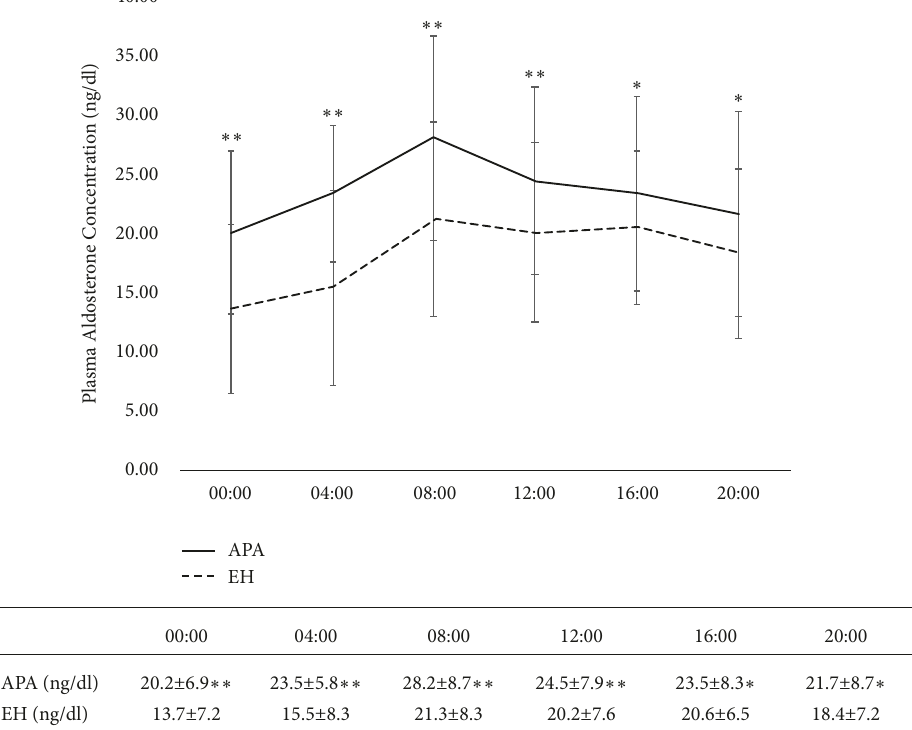
Figure 1: The circadian change in relation to plasma aldosterone concentration vs. that in the EH group. ∗ P < 0.05; ∗∗ P < 0.01. Note: the solid line refers to patients with APA, while the dashed line refers to patients with EH. APA, aldosterone-producing adenoma; EH, essential hypertension.